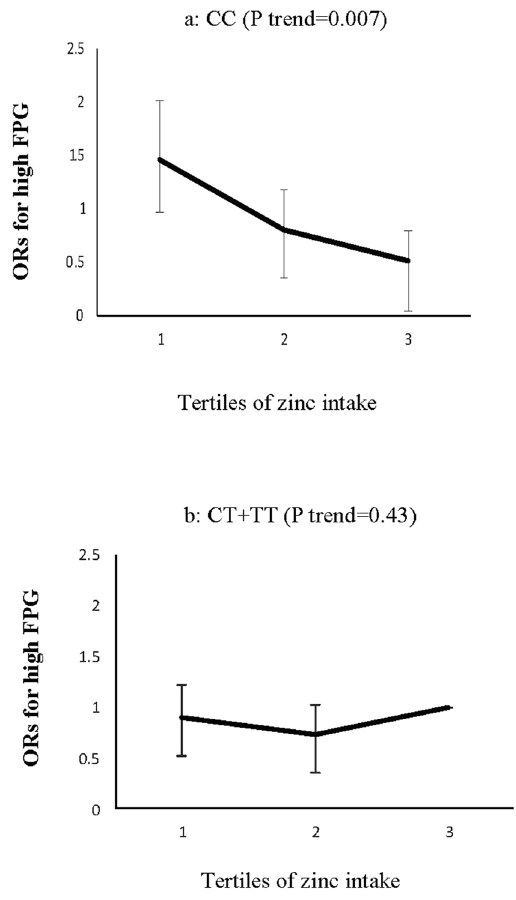
Figure 2. Adjusted ORs for high FPG (Fasting Plasma Glucose) across tertiles of zinc intake by the ZNT8 genotypes (P interaction = 0.05); CIs are shown after the bootstrap analysis (T1 < 10.52 mg, T2:10.52–14.24 mg, T3 > 14.24 mg), in the CC genotype carriers, the risk of high FPG decreased across tertiles of zinc intake (P trend = 0.007) ( a ), an association, however, not significant in the CT + TT genotype groups ( b